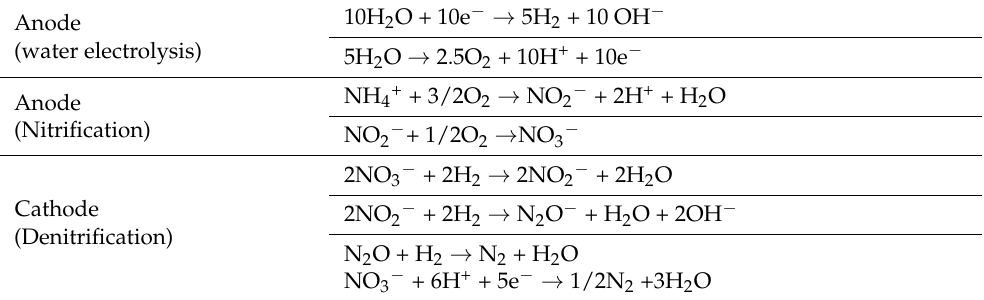
Table 1. The possible redox reactions involved in anode and cathode of MEC.